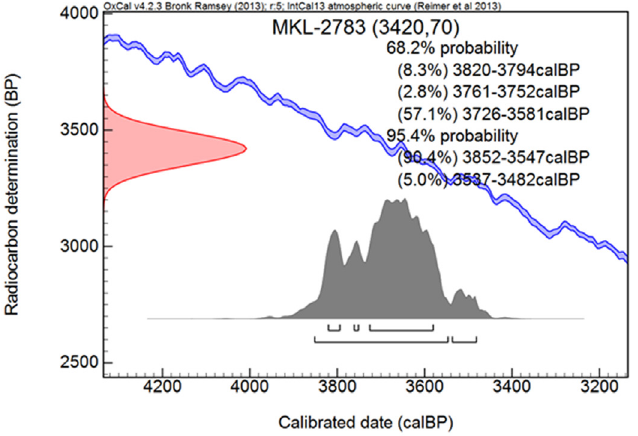
Figure 4. Calicantone. The C14 analysis of the individual n. 29 from the hut (sample n. MKL-2783). Chronology: 1570 ± 70 Cal. B.C. (3852–3547 cal. BP